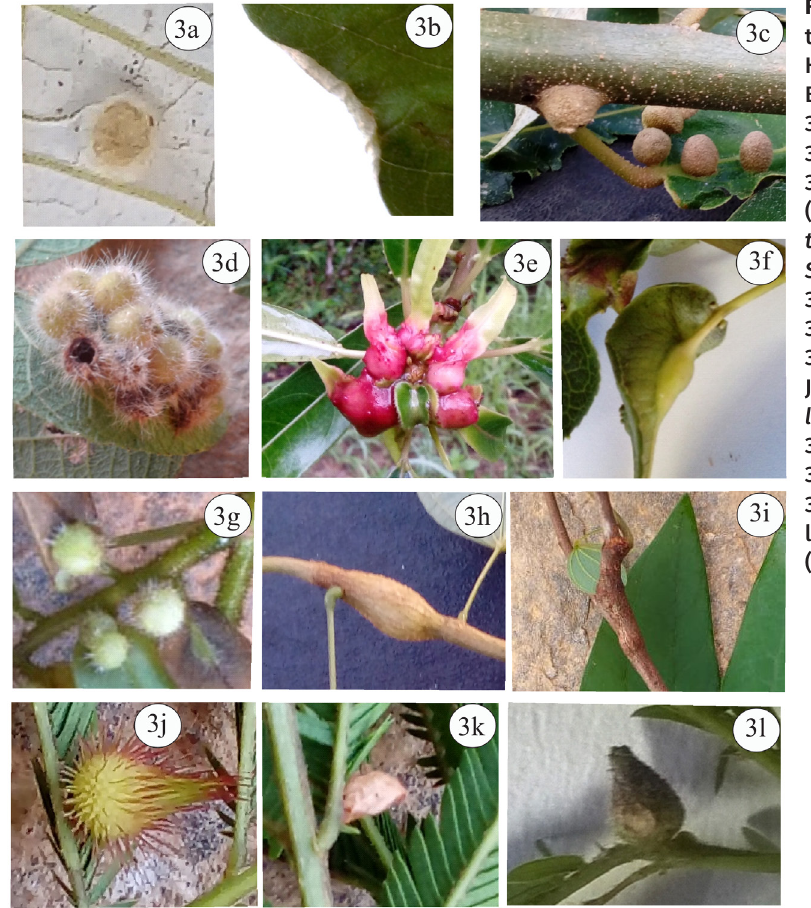
Figure 3. a-l. Insect galls found